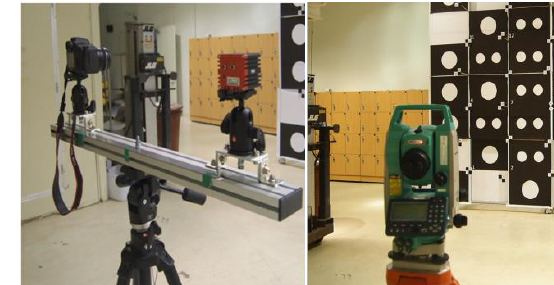
Figure 10. Optical and range sensor system(left), measuring GCP by using total station(right)